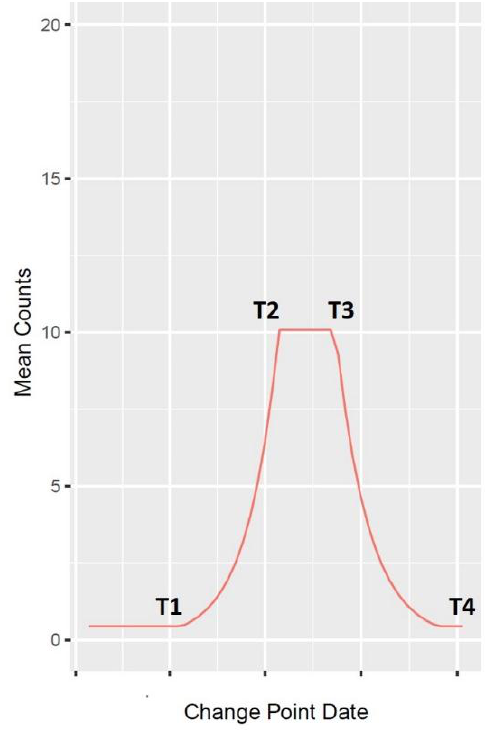
Figure 1. Change point plot description.